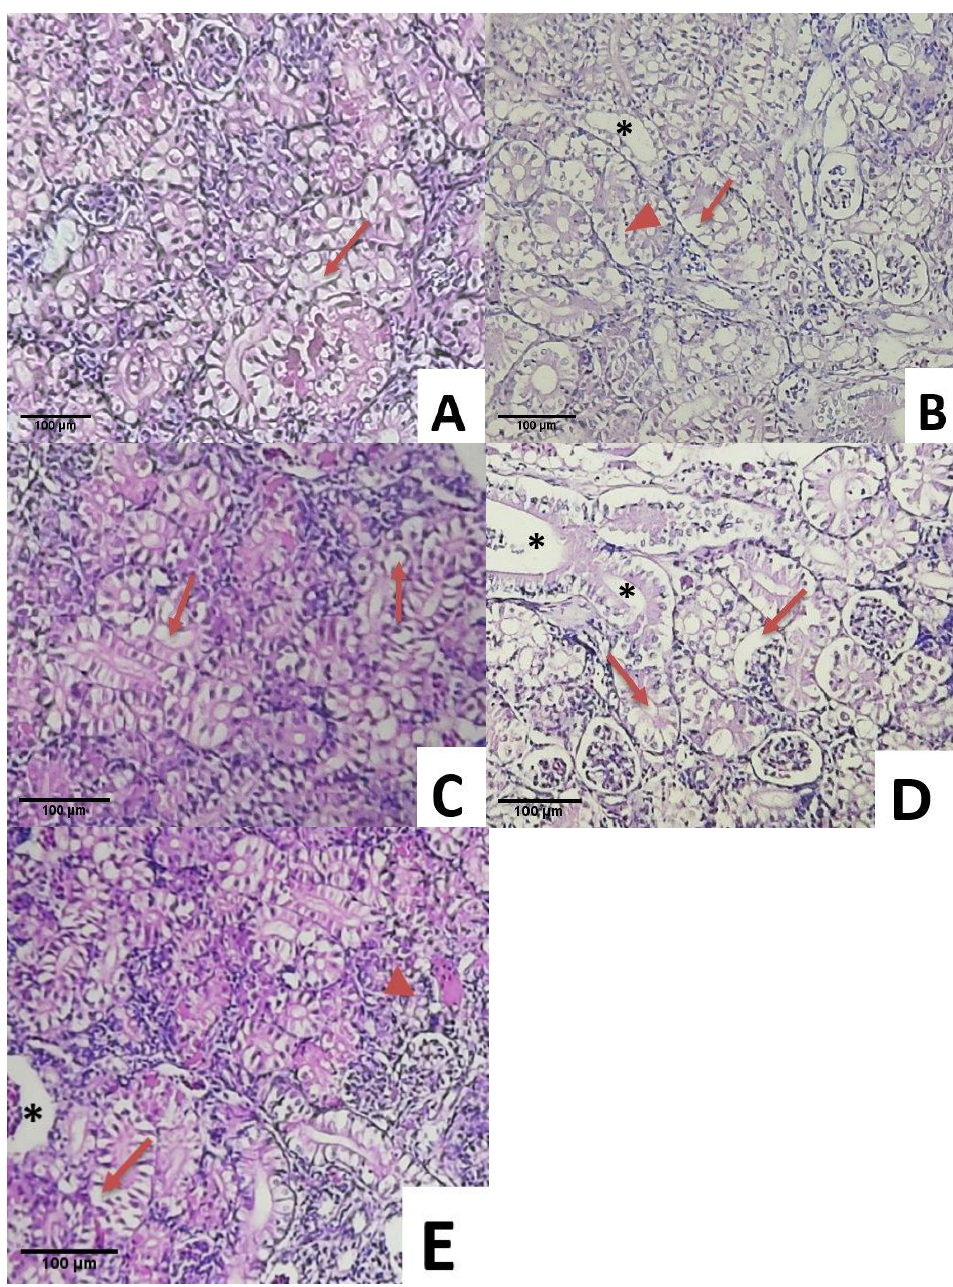
Figure 6. Histological changes in the kidneys of fish infected with Streptococcus agalactiae : ( A ).: Vacuolation (thin arrow) in CS, ( B ). Major vacuolation (thin arrow) necrosis and pyknotic nuclei (short arrow) and tubule necrosis (asterix) in S1 ( Streptococcus agalactiae ), ( C ). Vacuolation (thin arrow), pyknotic nuclei (short arrow) and tubule necrosis (asterix) in S2 (Biofloc + Streptococcus agalactiae ), ( D ). Major vacuolation (thin arrow) tubule necrosis (asterix) in S3 (Biofloc + MG1 + Streptococcus agalactiae ), ( E ). Slight vacuolation (thin arrow) in S4 (Biofloc + MP + Streptococcus agalactiae ) (HE staining, 100× magnification).